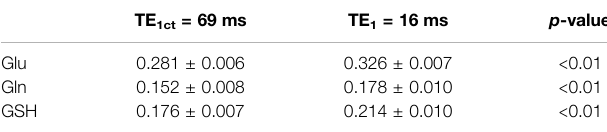
TABLE 2 | Comparison of Glu, Gln, and GSH peak amplitude/concentration valuesextractedfromthepreviousstudy(8healthyparticipants,TE=106 ms, TE 1 = 69 ms) and the current study (3 healthy participants, TE = 106 ms, TE 1 = 16